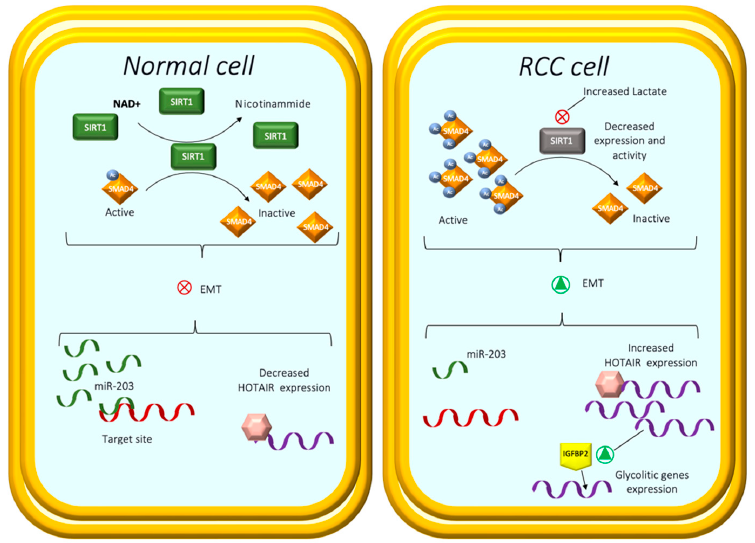
Figure 1. In normal cells, SIRT1 suppresses EMT and metastasis process by deacetylating SMAD4. In RCC, decreased SIRT1 activity and subsequent increased β -catenin protein levels promote an EMT-invasive phenotype. The expression levels of miR-203 in RCC cancer cells are lower than in normal cell lines. miR-203 binds toa target site and attenuates HOTAIR expression. HOTAIR enhances RCC cell migration by regulating the IGFBP2 expression. The HOTAIR–IGFBP2 axis induces glycolytic gene expression, correlating with increased proliferative and migratory capacity.